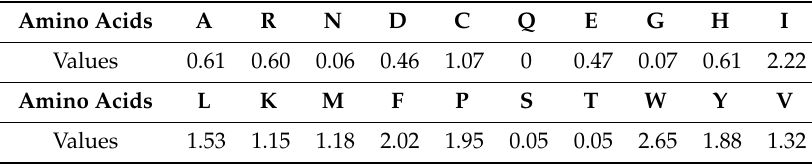
Table 6. The values of the hydrophobicity property for each amino